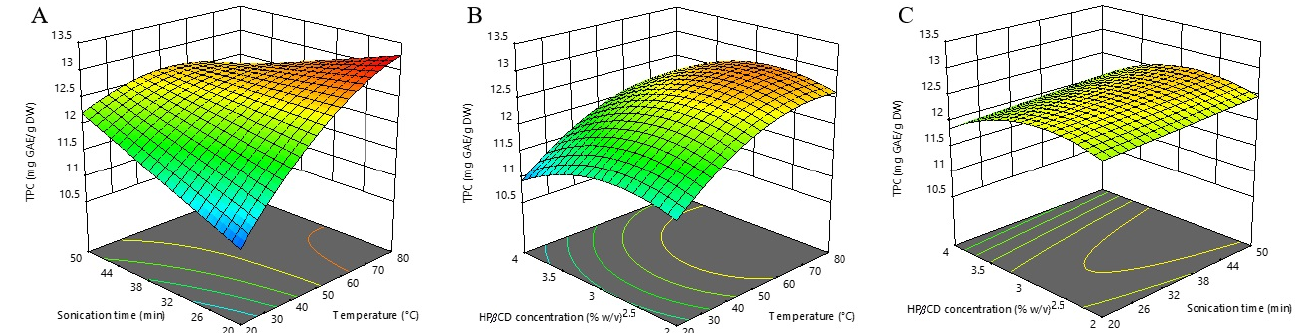
Figure 1. Three-dimensional response surfaces plots of total phenolics (TPC) as a function of sonication time/temperature ( A ); hydroxypropyl- β -cyclodextrin (HP β CD) concentration/temperature ( B ); and HP β CD concentration/sonication time ( C ).